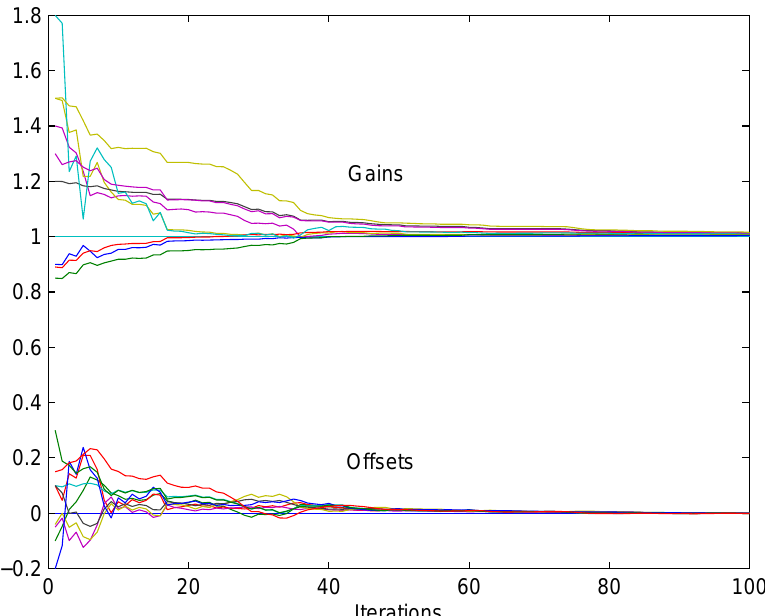
Figure 4. Noiseless synchronous algorithm with one reference sensor: convergence to the reference is chieved.